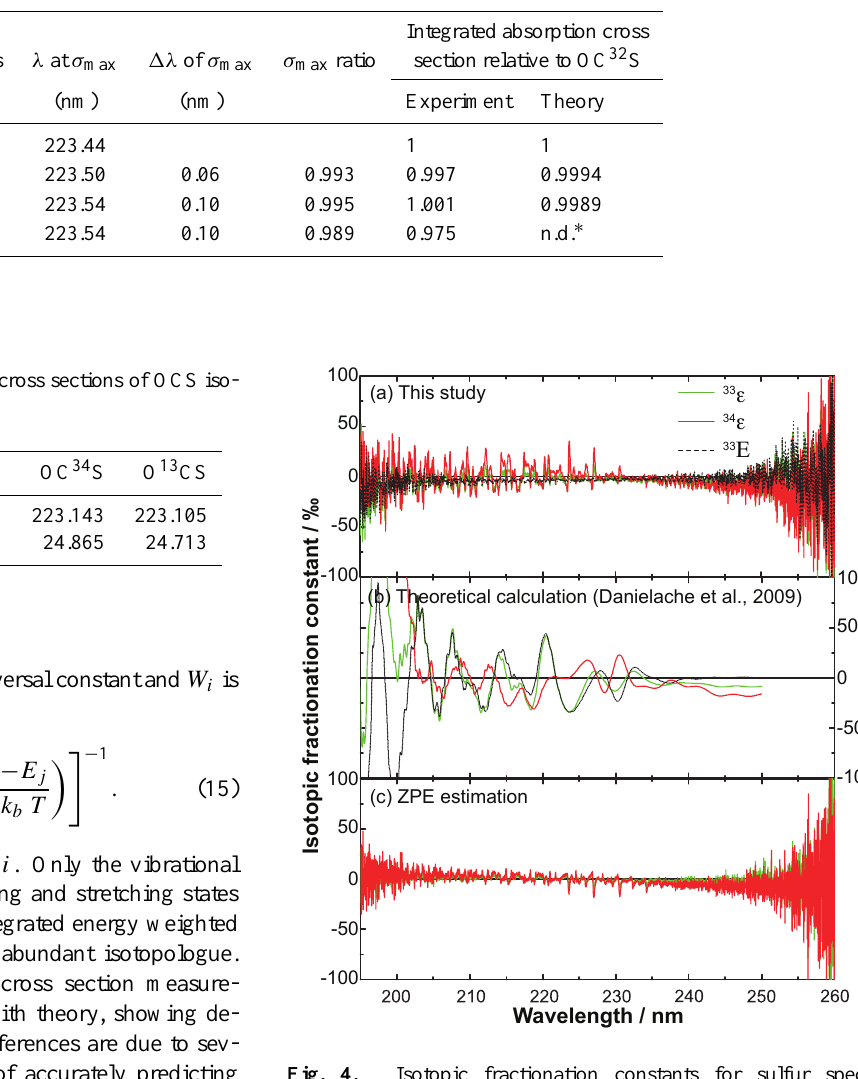
and 5), but the trend of the wavelength dependence of iso- topic fractionation can be seen. Generally it is close to zero on average on the higher energy side (195–230 nm) in both 33